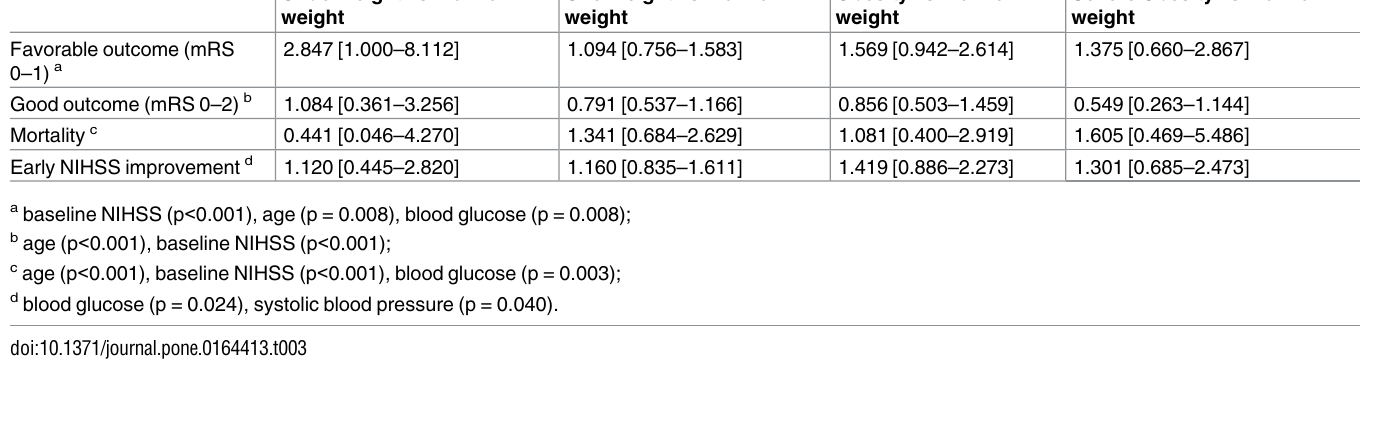
improvement in univariate analysis were age, diabetes mellitus, baseline blood glucose and sys- tolic blood pressure at admission. For sICH no model could be fitted due to singularity because no sICH was observedin the group of underweight and severely obese patients. Univariate analyses showed no association between different BMI categories and functional outcome, mortality or the occurrenceof sICH. BMI categories set in reference to normal weight patients and were defined as follows: < 18.5 kg/m 2 for underweight,18.5 to 24.9 kg/m 2 for nor- mal weight, 25.0 to 29.9 kg/m 2 for overweight, 30.0 to 34.9 kg/m 2 for obesity and (cid:21) 35 kg/m 2 for severe obesity. Results are presented as odds ratio with 95% confidence intervals. ( (cid:3) ) Asterix labels the normal weight reference group. Letters a–d denote significant associations in univari- ate analysis (see footnotes). Abbreviations: BMI (body mass index), OR (odds ratio), CI (confi- dence interval), mRS (modifiedRankin Scale), sICH (symptomatic intracerebral hemorrhage), NIHSS (National Institute of Health Stroke Scale), n.a. (not applicable). After multivariate analyses, the outcomes still did not differ among BMI categories as com- pared to the normal weight group (Table 3). Although underweight patients showed a trend towards a favorable outcome (mRS 0–1), one has to consider the broad confidence intervals. Table 3. Multivariate outcome analyses according to BMI categories. Outcome measures Underweight vs. normal Overweight vs. normal Obesity vs. normal Severe Obesity vs. normal weight weight weight